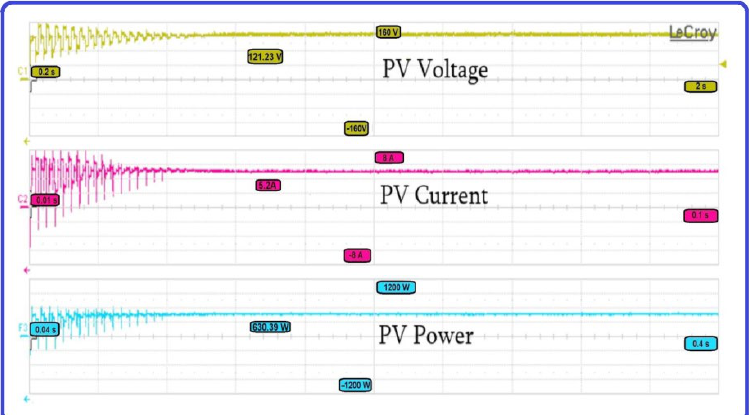
Figure 14. Experimental results of MPA technique for case 2.